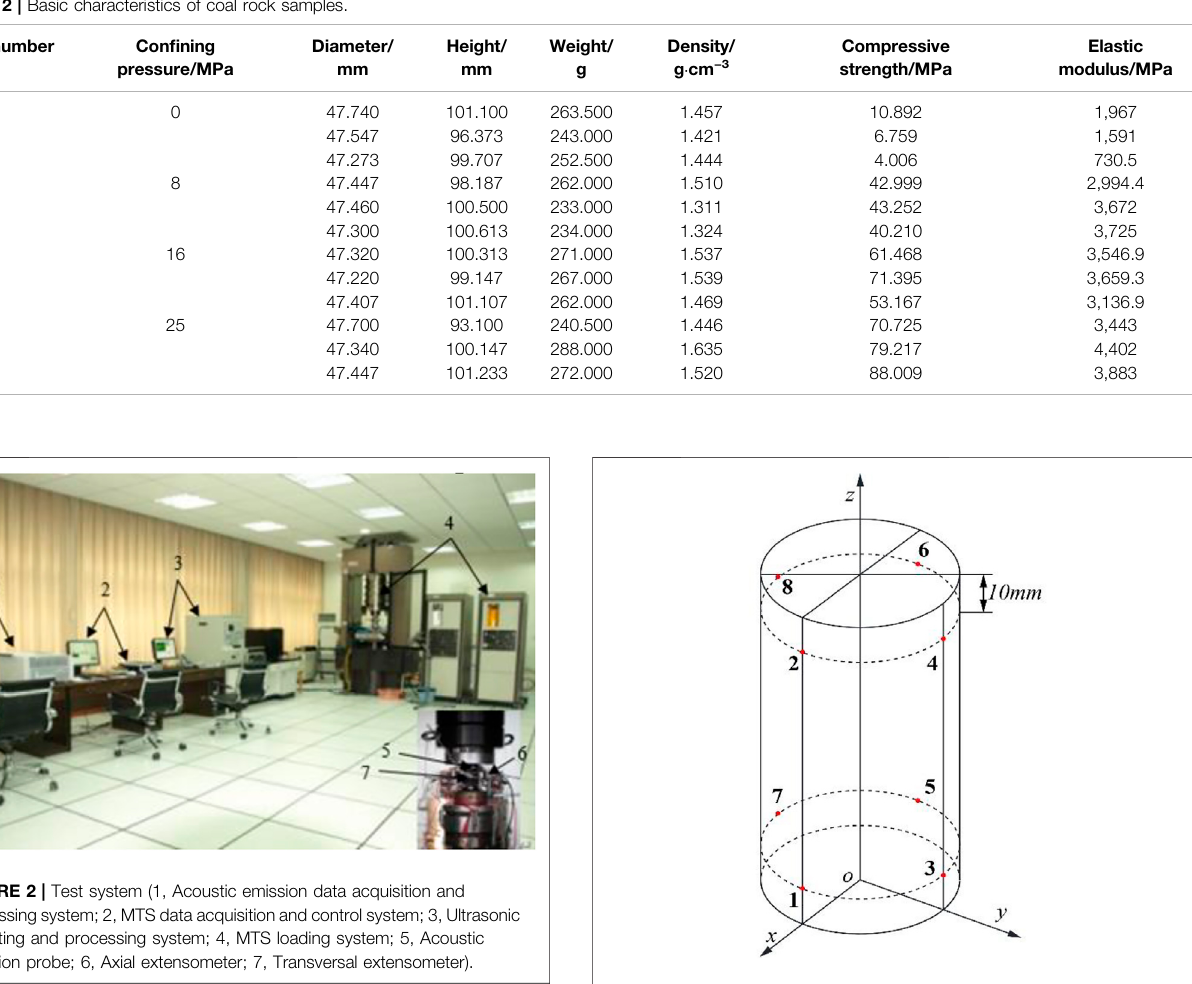
FIGURE 3 | Arrangement of acoustic emission